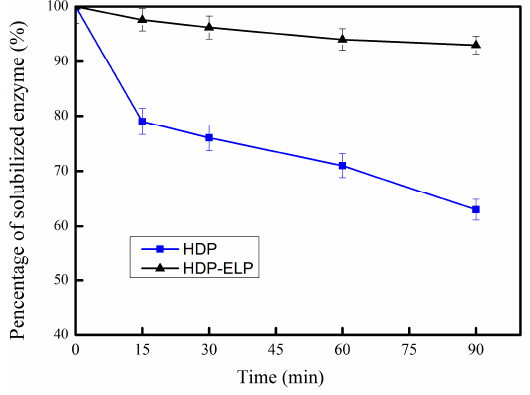
Figure 2. Comparison of enzyme solubility in aqueous solution.